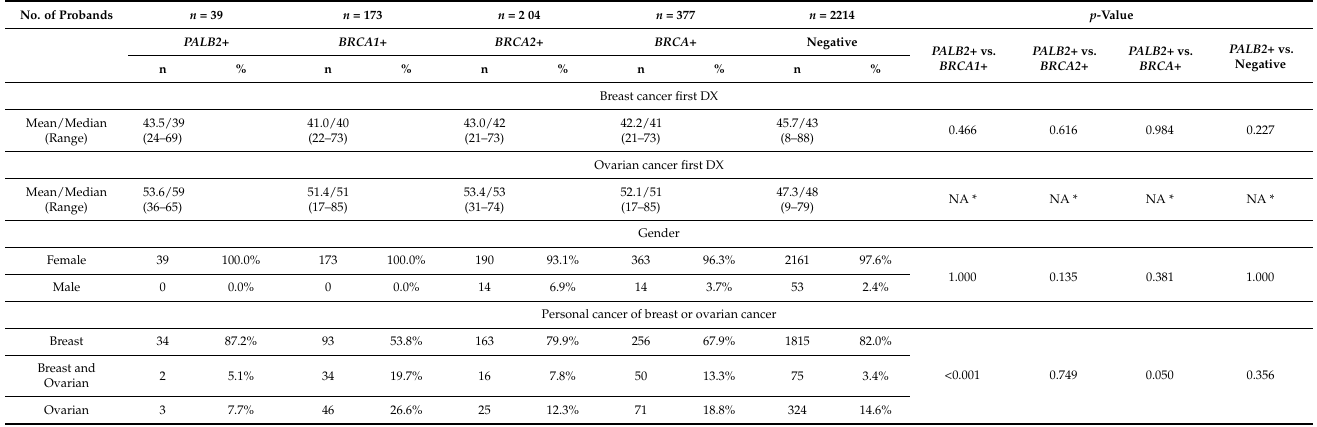
Table 2. Characteristics and mutation frequencies of PALB2 and BRCA1/2